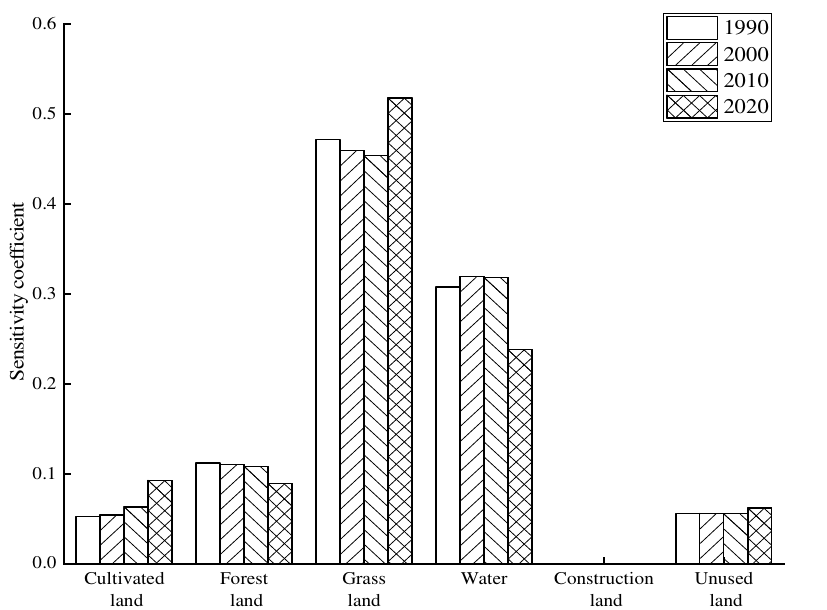
Figure 4. Sensitivity coefficients of the ESV for various land-use types in Xinjiang from 1990 to